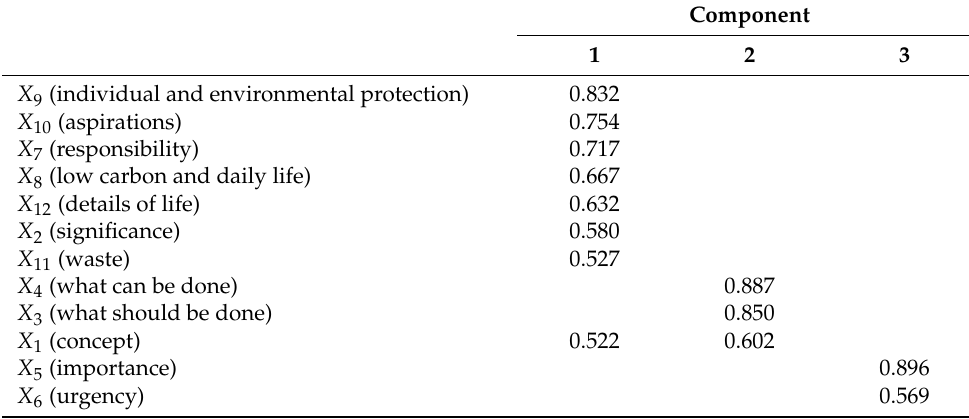
Table 7. Rotated Component Matrix (showing only loads greater than 0.5).